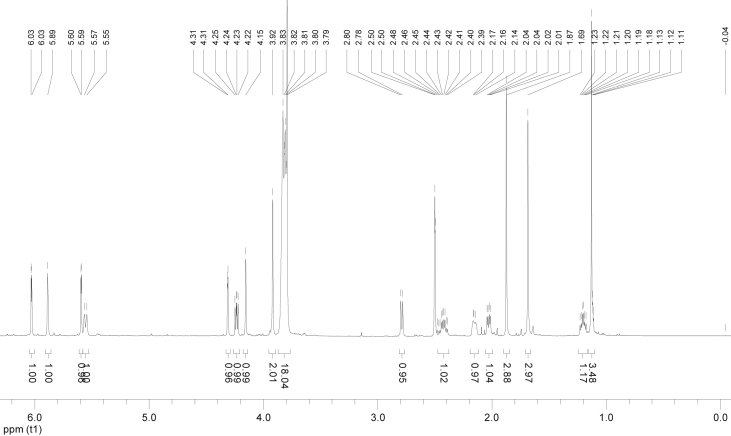
1H NMR (DMSO-d6+ D2O) spectrum of compound 5.